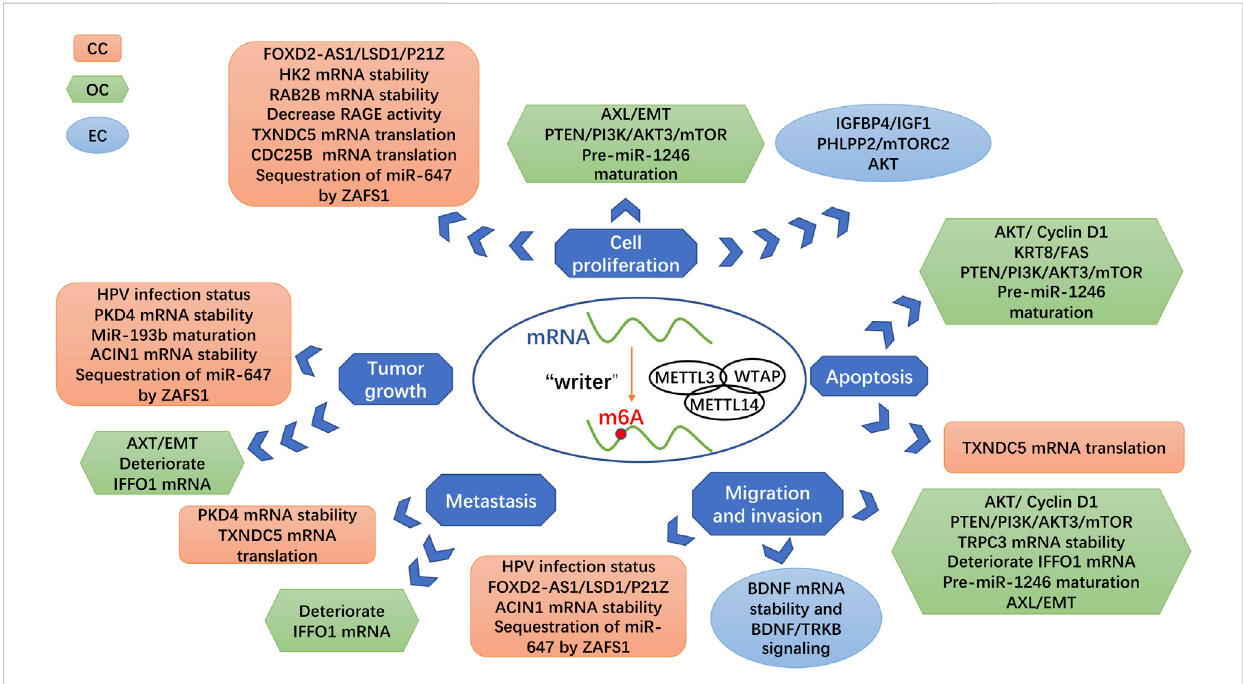
FIGURE 3 Roles of Mettl3 as a methyltransferase in gynecologic cancers. Different targets of Mettl3 are linked with various signaling pathways and biological processes, which generate the different in fl uences of Mettl3 in gynecologic